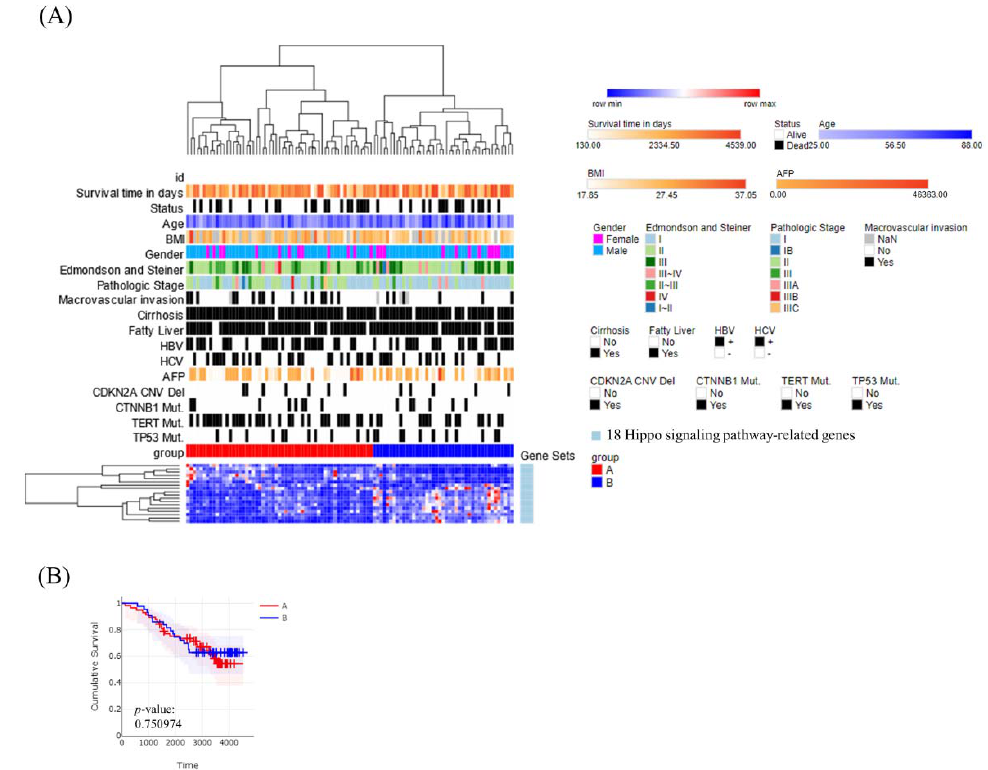
Figure 2. Molecular classification of Taiwanese HCC patients using a panel of 18 Hippo pathway genes. ( A ) Heatmap showing normalized expression levels of the 18 signature genes (rows) across subjects (columns) divided into two molecular subclasses ( A , B ) using an unsupervised approach. Each signature gene was significantly up- or downregulated compared with the other subclasses, as indicated by color changes, where blue and red indicates low and high expression, respectively. Signature genes and subjects were hierarchically clustered within each class. Significant differences in demographic characteristics, clinical annotations, molecular subclasses, and hepatitis B and C virus infection status across subjects are shown at the top of the figure. ( B ) Overall survival of subjects in each molecular subclass.